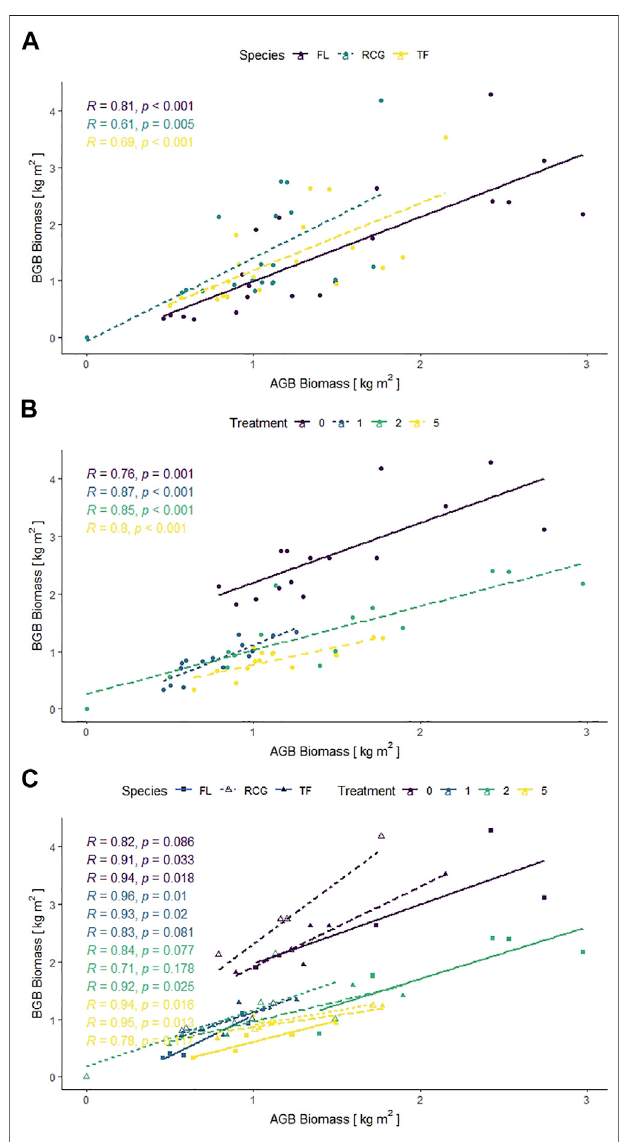
FIGURE 4 | Pearson correlation showing the relation between aboveground (AGB) biomass (kg m − 2 ) and belowground (BGB) biomass (kg m − 2 ) for (A) species and treatment, (B) treatment across species, and (C) species across treatments.